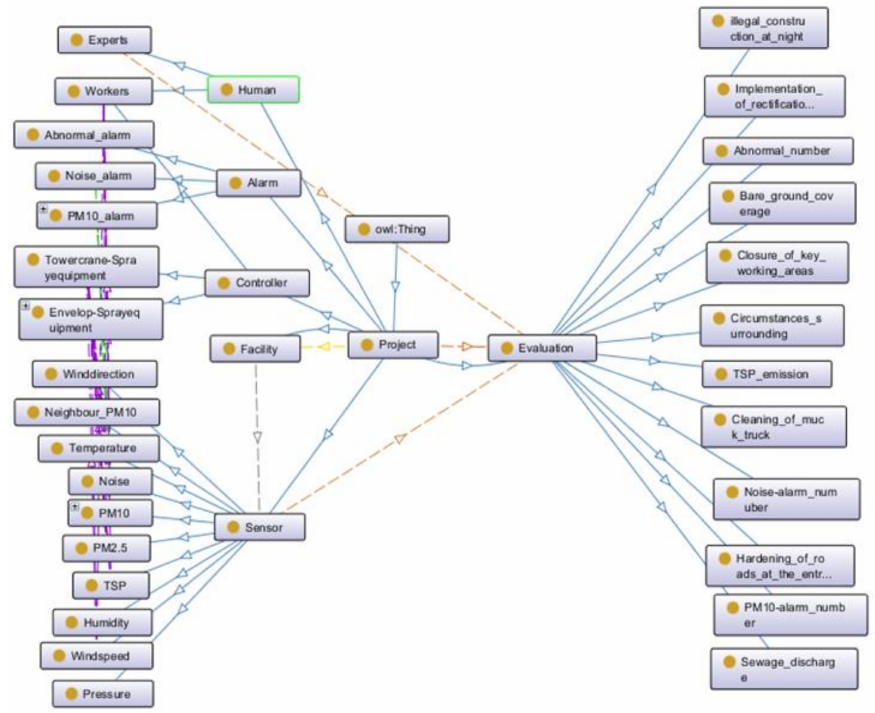
Figure 4. The ontologies in the E-CPS